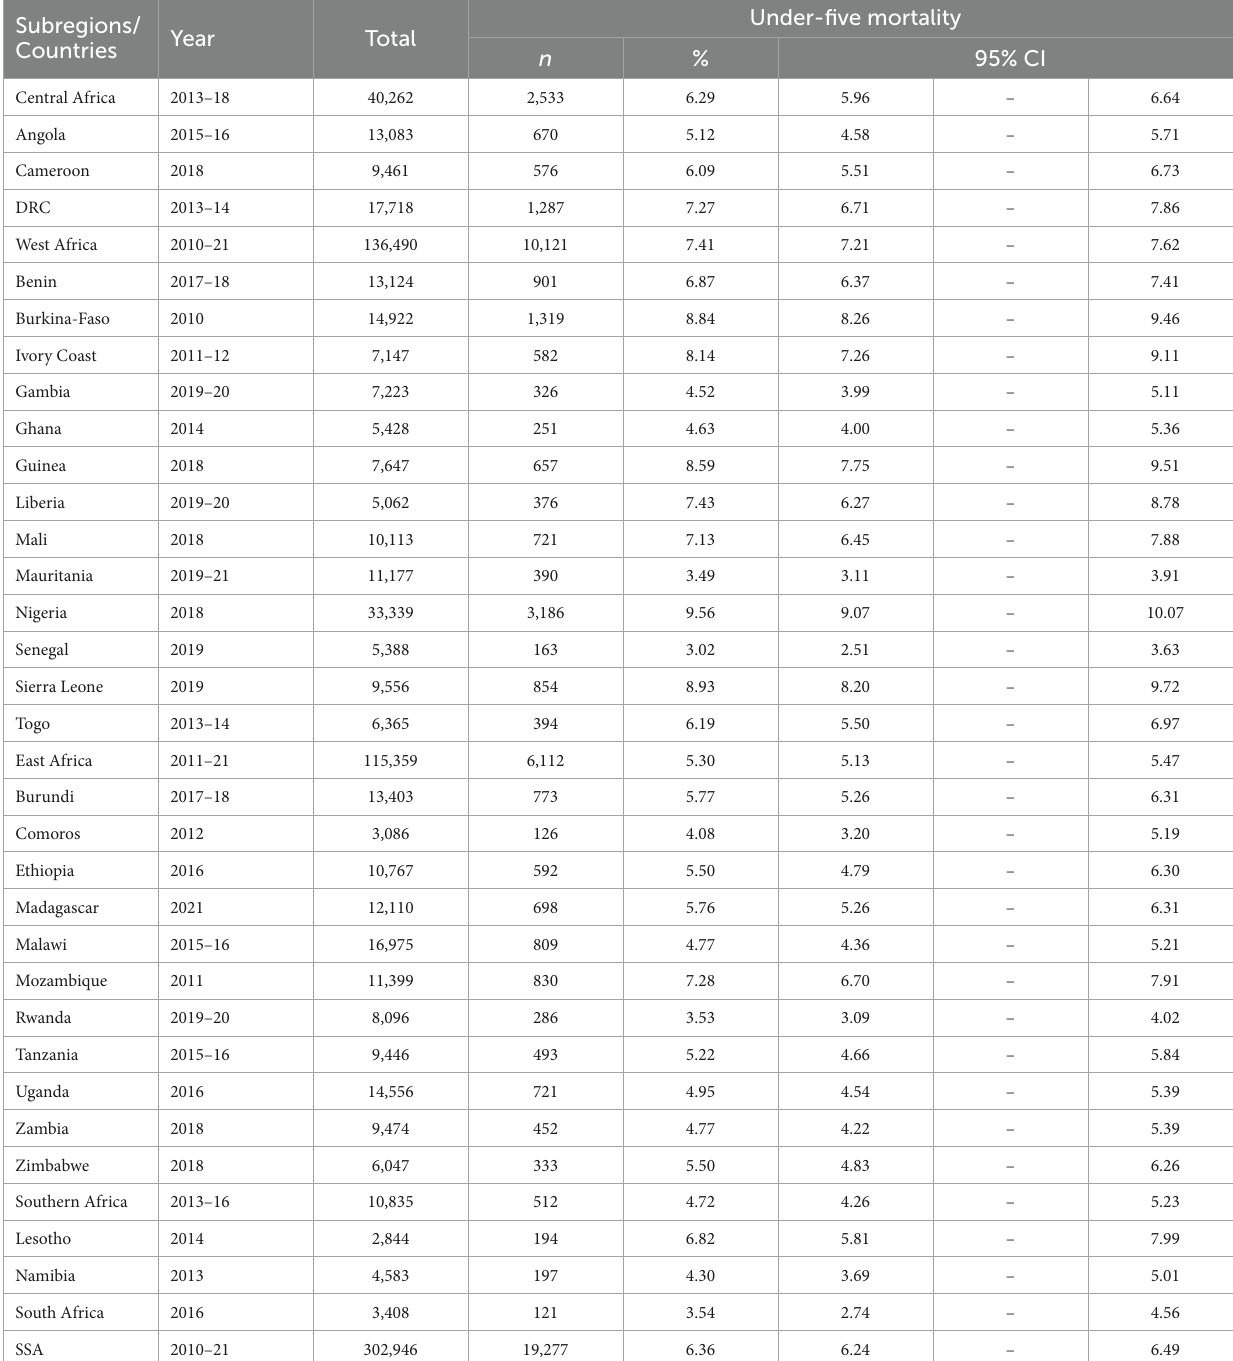
TABLE 4 Under-five mortality by country in Sub-Saharan Africa,